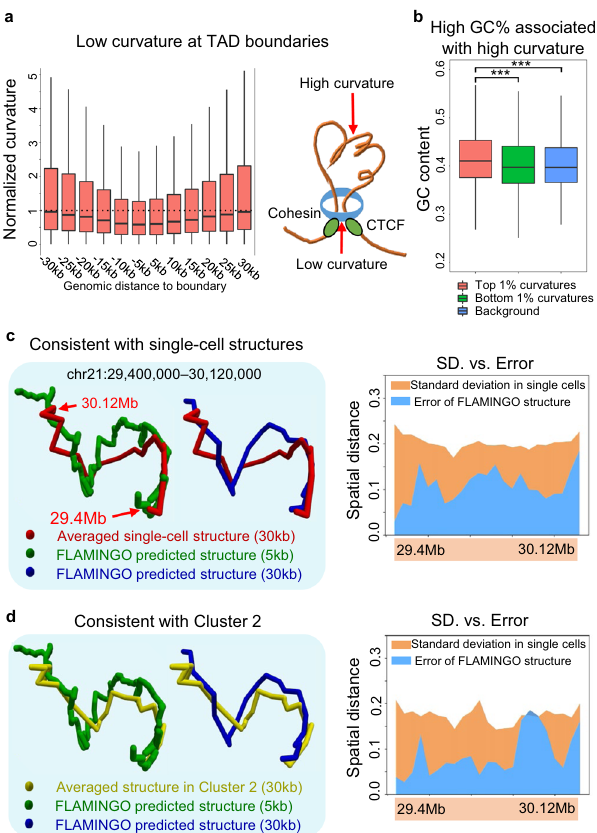
Fig. 5 Geometrical signatures of predicted chromatin con fi guration and its comparison to single-cell structures. a TAD boundaries demonstrate lower curvatures than fl anking genomic regions. The center lines of boxplots ( n = 11,208) show the median of normalized curvatures, the upper and lower box limits show the 25th and 75th percentiles respectively. The whiskers extend up to 1.5 times the interquartile range away from the limits of the boxes. Outliers outside this range were removed from the fi gure. b The regions with high curvatures show higher GC-content compared with genomic background. One-sided Mann – Whitney test *** p -value = 2.7 × 10 − 29 (green, n = 5261) and p -value = 3.4 × 10 − 34 (blue, n = 5261). The center lines of boxplots ( n = 5261) show the median, the upper and lower box limits show the 25th and 75th percentiles respectively. The whiskers extend up to 1.5 times the interquartile range away from the limits of the boxes. Outliers outside this range were removed from the fi gure. c The consensus structure predicted by FLAMINGO consistently aligns with the average structure across single cells in K562. Right: the errors between the predicted consensus structure and the average structure (blue) are smaller than the intrinsic standard deviations among single cells (orange). d The consensus structure predicted by FLAMINGO is in strong agreement with the average structure across the subset of cells in cluster 2. Right: the errors between the predicted consensus structure and the cluster-2 speci fi c average structure (blue) are smaller than the intrinsic standard deviations among single cells in cluster 2 (orange). Source data are provided as a Source Data fi